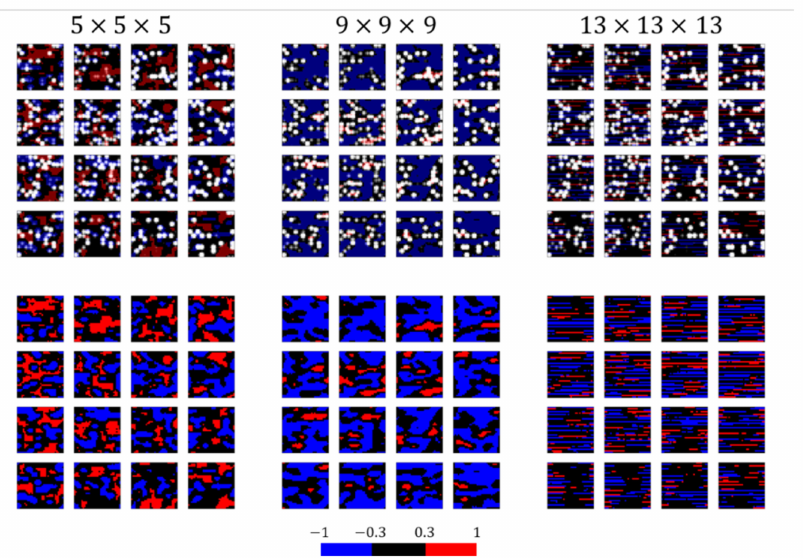
Figure 12. Input and convoluted images obtained using the kernels with sizes of 5 × 5 × 5, 9 × 9 × 9, and 13 × 13 × 13. The upper row represents the superimposed images of input and convoluted images. The white circles and black areas denote the filler particles and rubber regions in the input images, respectively. The red and blue areas are visualized in the convoluted images depicted in the lower row and represent the pixels with positive and negative values, respectively. The red areas contribute to the positive example, and the blue areas contribute to the negative example. The pixels with values ranging from − 0.3 to 0.3 are visualized in black to emphasize the areas with large